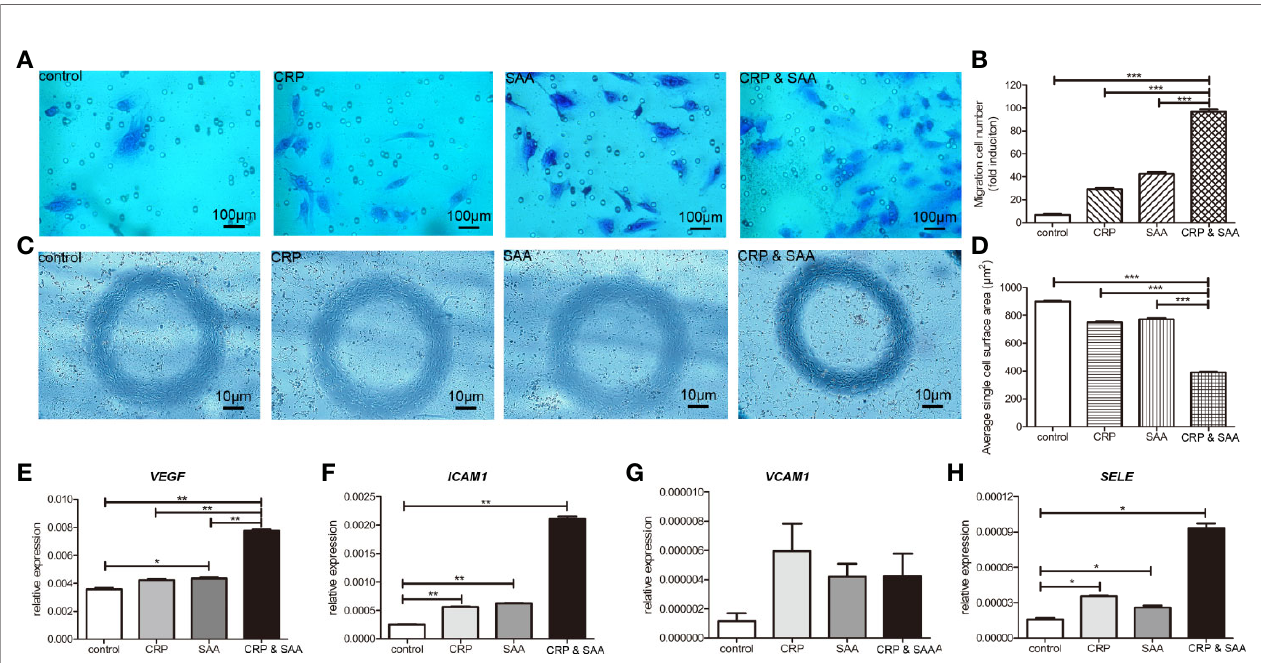
FIGURE 3 | Migration of HUVECs cultured in medium with or without stimulation was performed in a Transwell chamber with 8.0 m m pore size. Representative images of HUVECs that migrated through the membrane (A) and the number of cells that migrated through the membrane/ fi eld (B) were presented. Values were expressed as the mean ± SD. n = 3. (C) . HUVECs were stimulated for 18 h and the representative images were captured to show the cell shape of HUVECs. The combination of CRP and SAA produced cells with a constricted morphology with long membrane extensions compared to negative control or either one of them. (D) Quanti fi cation of the change in cell morphology by measurement of cell surface area. For each condition, a minimum of 150 cells from three experiments was examined. The relative expression of angiopoietin-like proteins, including VEGF (E) , ICAM1 (F) , VCAM1 (G) , and SELE (H) in the groups of HUVEC treated with the control, or CRP, or SAA, or combination of CRP and SAA. The asterisk indicates signi fi cant difference in cell surface area compared to the control, using the Student t-test (* P < 0.05, ** P < 0.01, *** P <